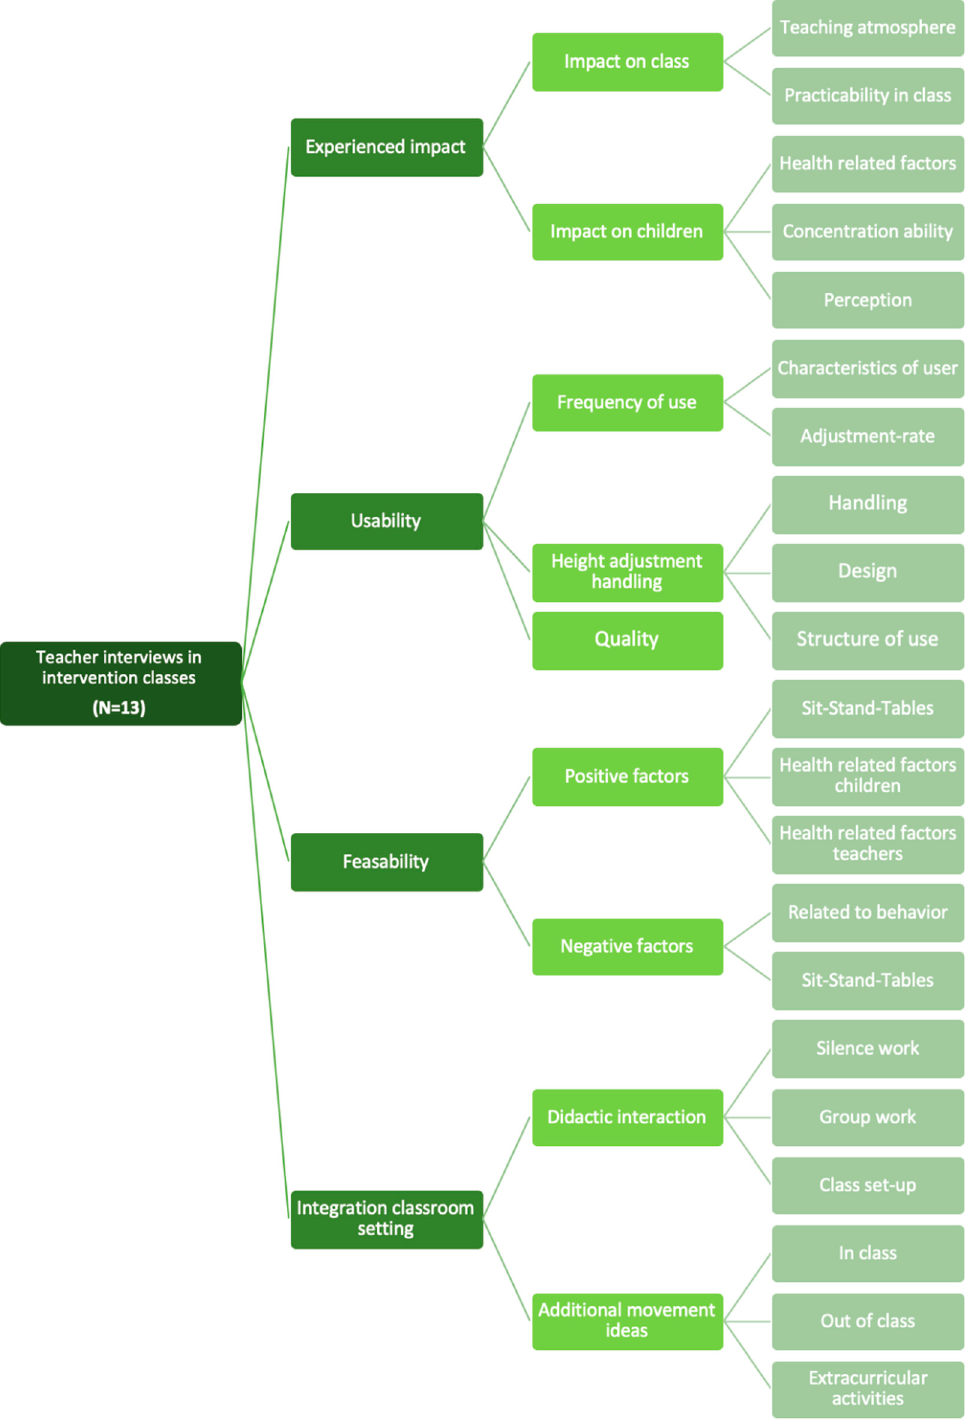
Figure 3. Coding scheme of the semi-structured interviews with teachers of the intervention group.